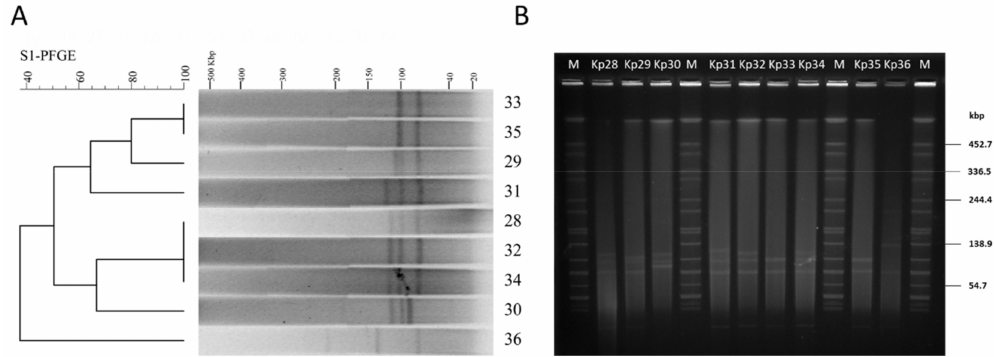
Figure 1. S1-pulsed-field gel electrophoresis analysis of isolated K. pneumoniae strains. ( A ) S1-pulsed-field gel electrophoresis fingerprint of the isolates; ( B ) molecular epidemiology investigation of the isolates; lane M: marker ( Salmonella H9812); lane 28–36: